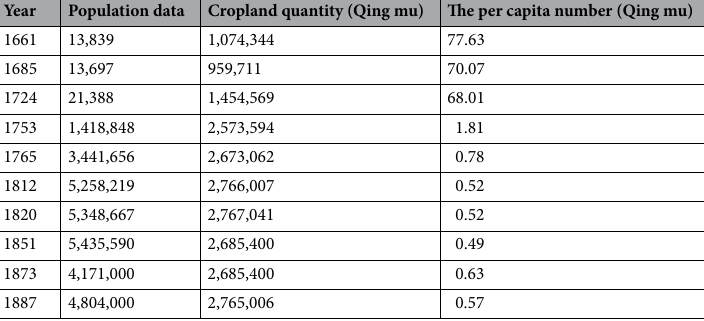
Table 3. Recorded population and cropland data in Guizhou during the Qing